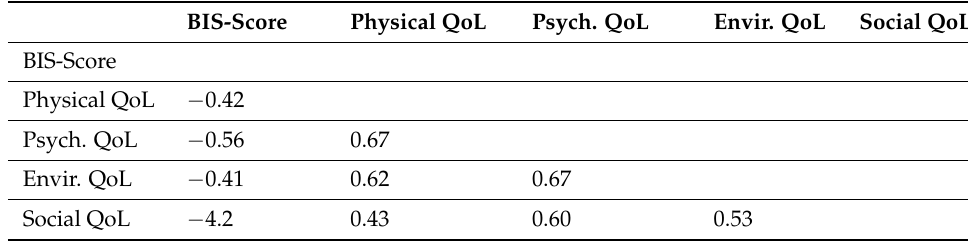
Table 4. Correlation matrix of the outcome